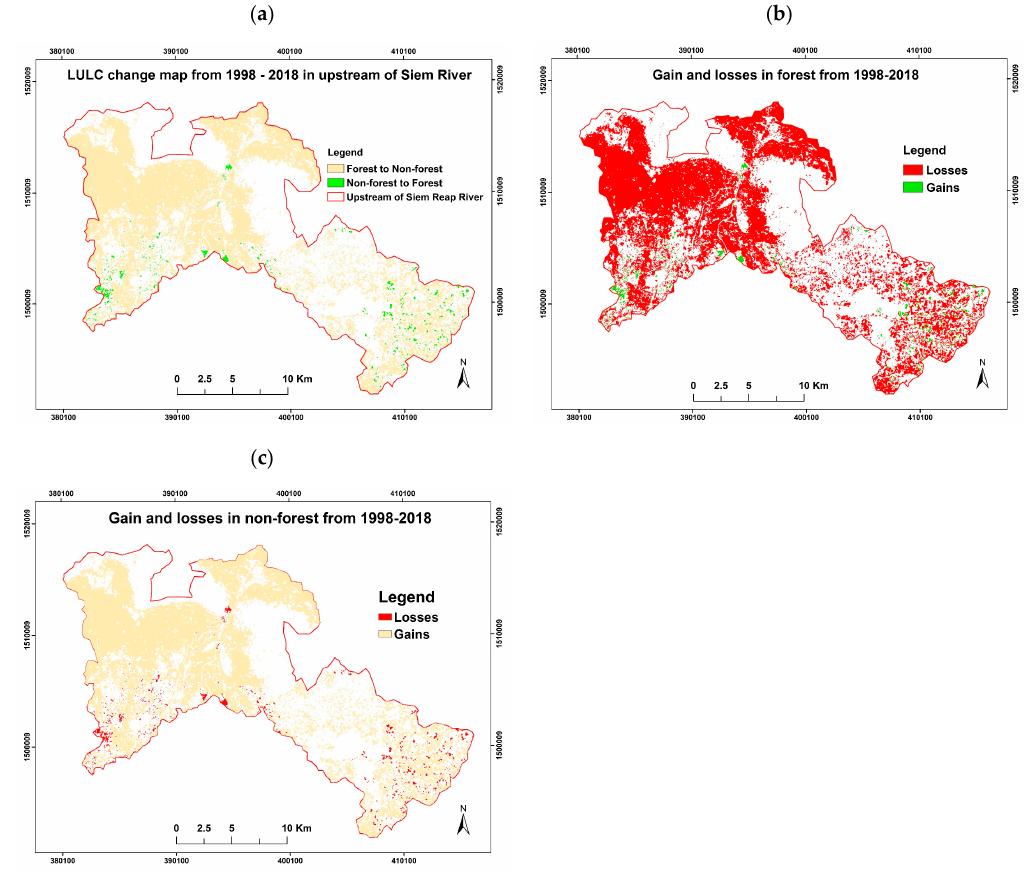
Figure 7. ( a ) LULC classes change during 1998–2018 and gains and losses of each class in from 1998 to 2018 ( b ) forest, and ( c ) non-forest.